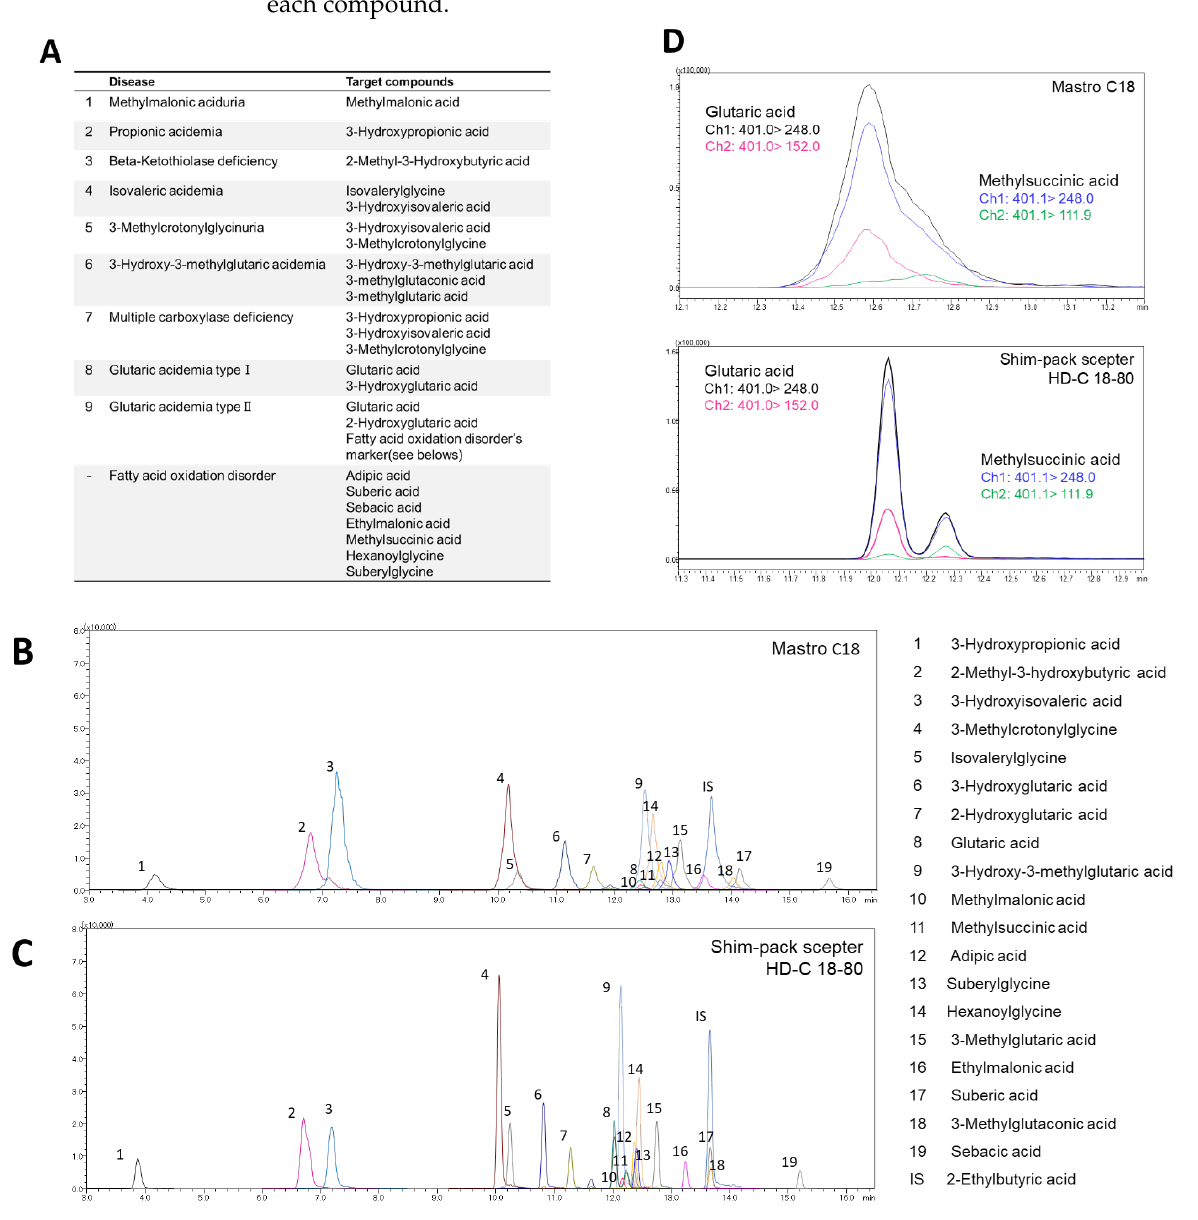
Figure 1. Investigation of LC separation conditions. ( A ) Targeted diseases and marker metabolites. MRM chromatogram of 3-NPH derivatized organic acids obtained from ( B ) MastroC18 and ( C ) Shim-pack sceptor HD-C18-80. ( D ) MRM chromatogram of glutaric acid and methylsuccinic acid on MastroC18 and Shim-pack sceptor HD-C18-80 column.